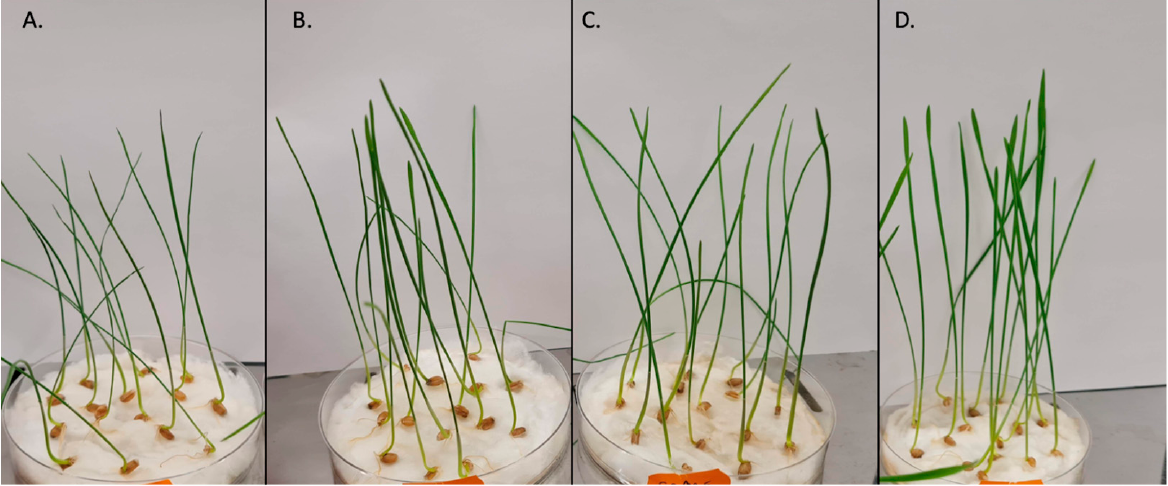
Figure 1. Wheat seedlings after 14 days of incubation. The control group ( A ) was watered only with water, while the other groups were treated with water fungal extracts obtained at 75°C: ( B ) pH = 7, concentration 0.5%; ( C ) pH = 3, concentration 2.5%; ( D ) pH = 10, concentration 0.5%.